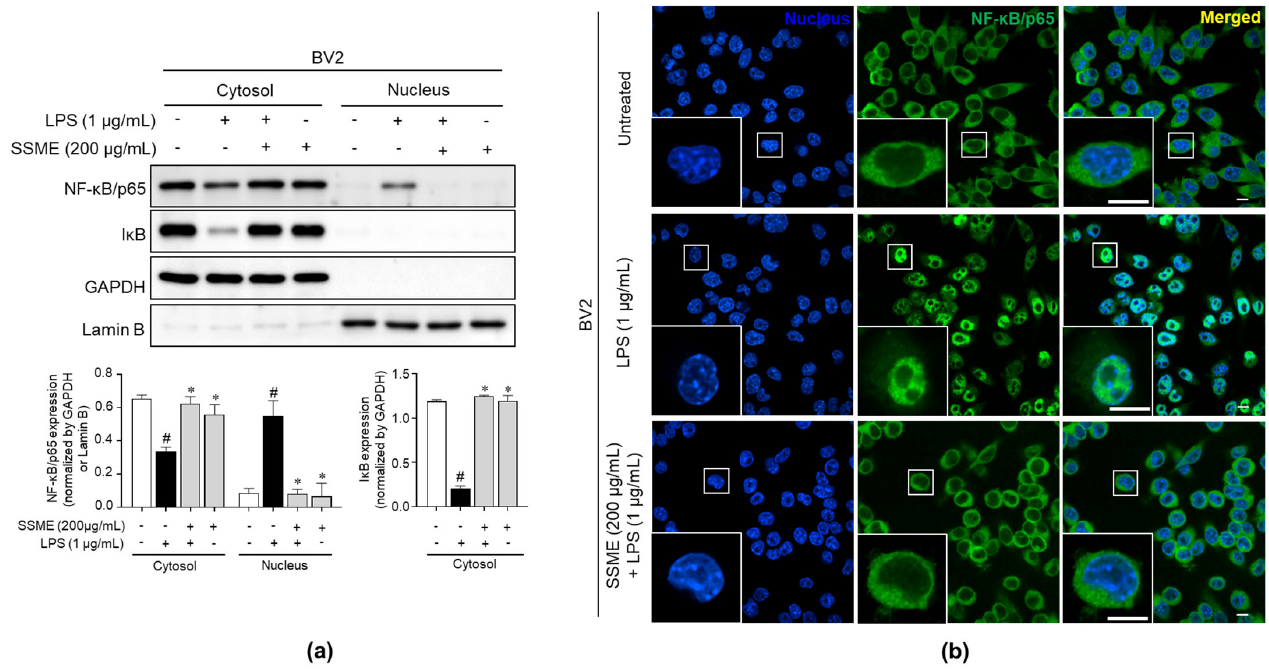
Figure 7. Inhibitory effects of the SSME on the NF- κ B signaling pathway. The BV2 cells were treated with SSME (200 μ g/mL) for 2 h, followed by stimulation with LPS (1 μ g/mL) for 15 min. ( a ) The expression of NF- κ B/p65 and I κ B was detected in the cytosolic and nuclear extracts using western blotting. ( b ) The cells were immunostained with anti-NF- κ B/p65 (green) antibody, and nuclei were stained with DAPI (blue). The cells were analyzed with confocal imaging microscopy. The data presented are the mean ± SEM of three independent experiments. Differences between groups were analyzed using the Mann–Whitney U test. # p < compared with the untreated and the LPS-treated groups; * p < 0.05, compared with the LPS-treated and SSME- and LPS-treated groups. NF- κ B, nuclear factor kappa-light-chain-enhancer of activated B cells; I κ B, inhibitor of κ B; DAPI, 4 ′ ,6-diamidino-2-phenylindole. Scale bar: 10 μ m.